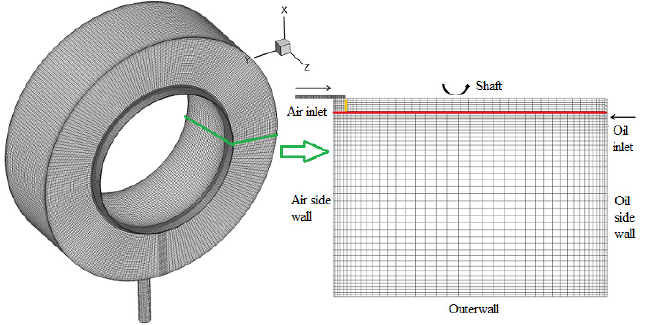
Figure 4. The overall grids and the cross-section of grids of 90°.